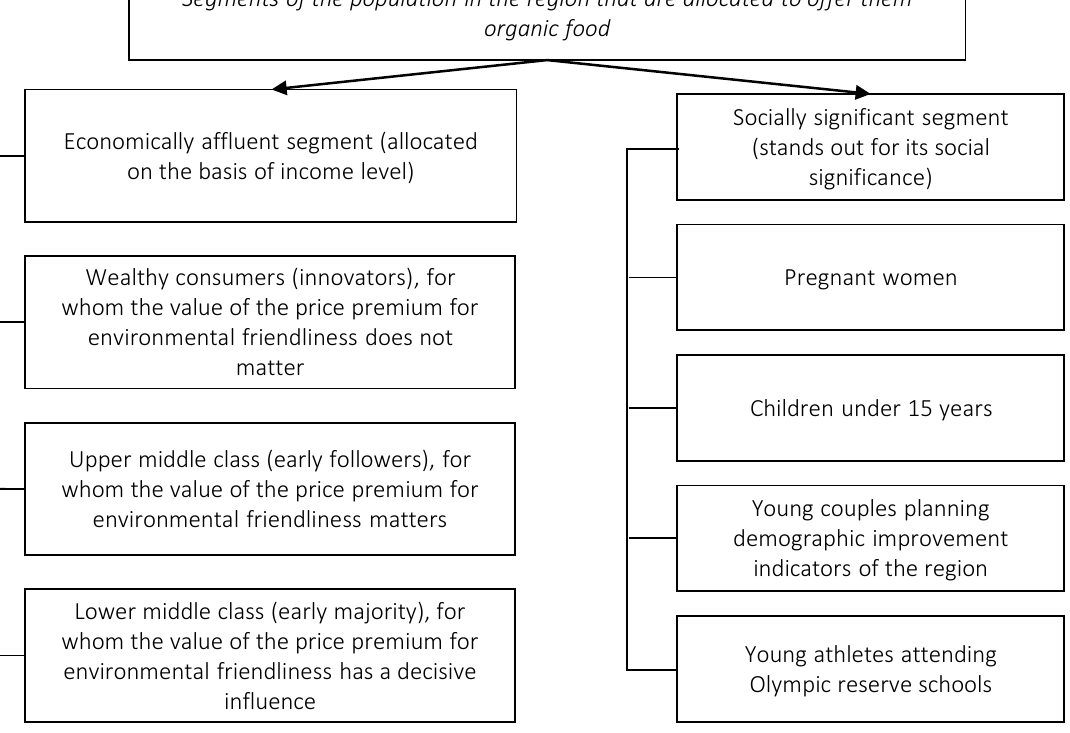
Segments of the population in the region that are allocated to offer